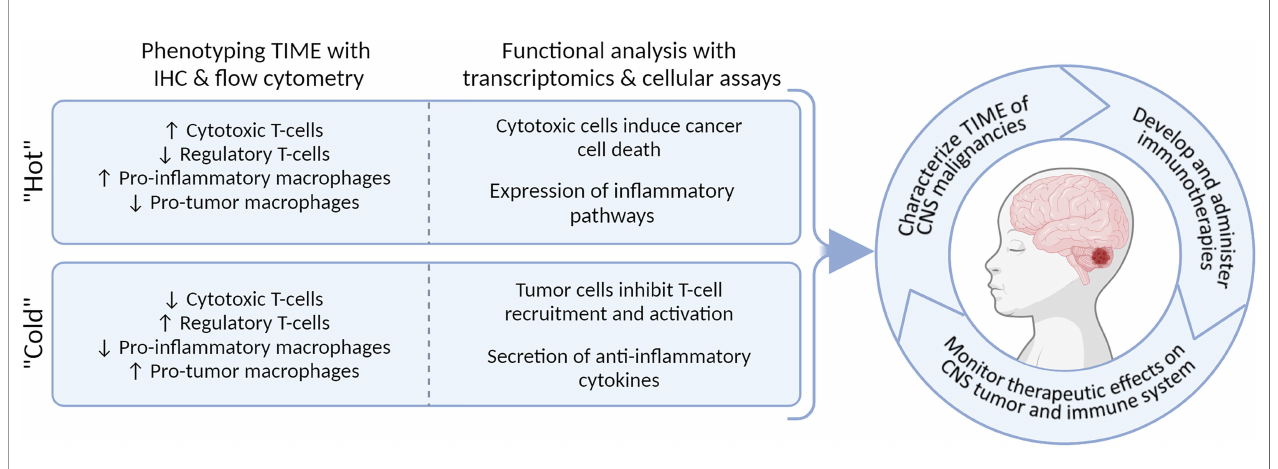
FIGURE 5 | Integrating methodologies allows for multi-dimensional characterization of TIME and will enable personalized immunotherapeutic